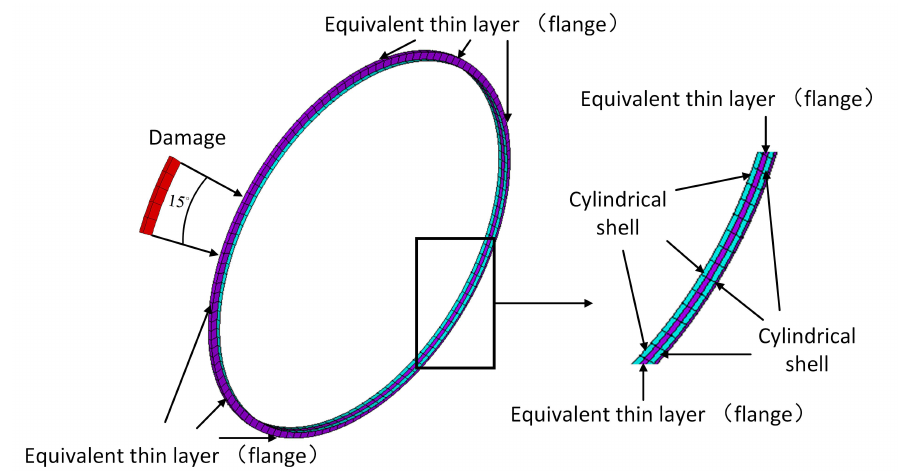
Figure 11. FEM model of a coupling element. The damage is induced by reducing 10/50% Young’s modulus of the thin-layer element at 0–15 degree. The blue part is the cylindrical shell; the purple part is the equivalent thin